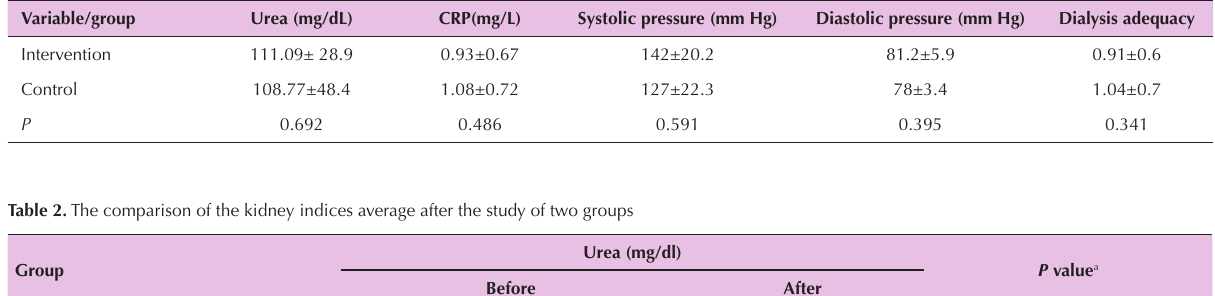
Urea (mg/dl) Before After